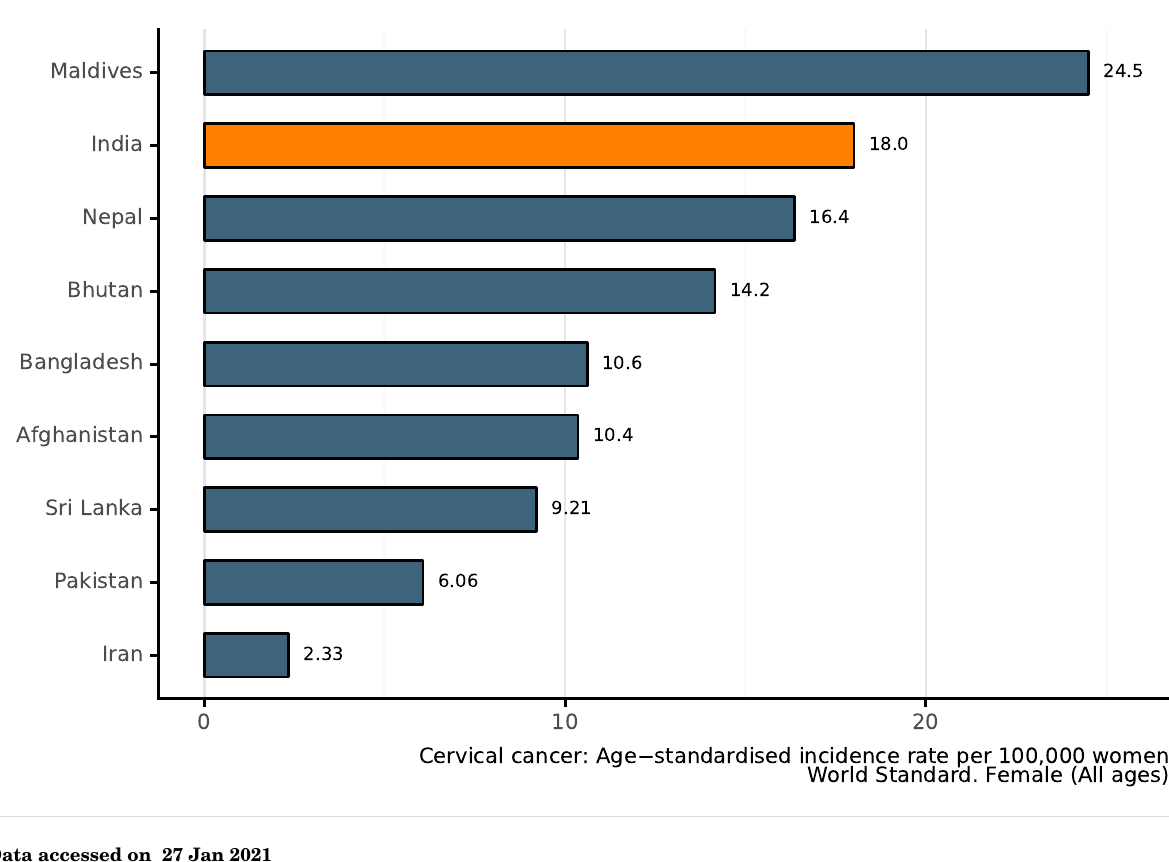
Figure 73: Age-standardised incidence rates of cervical cancer of India (estimates for 2020)